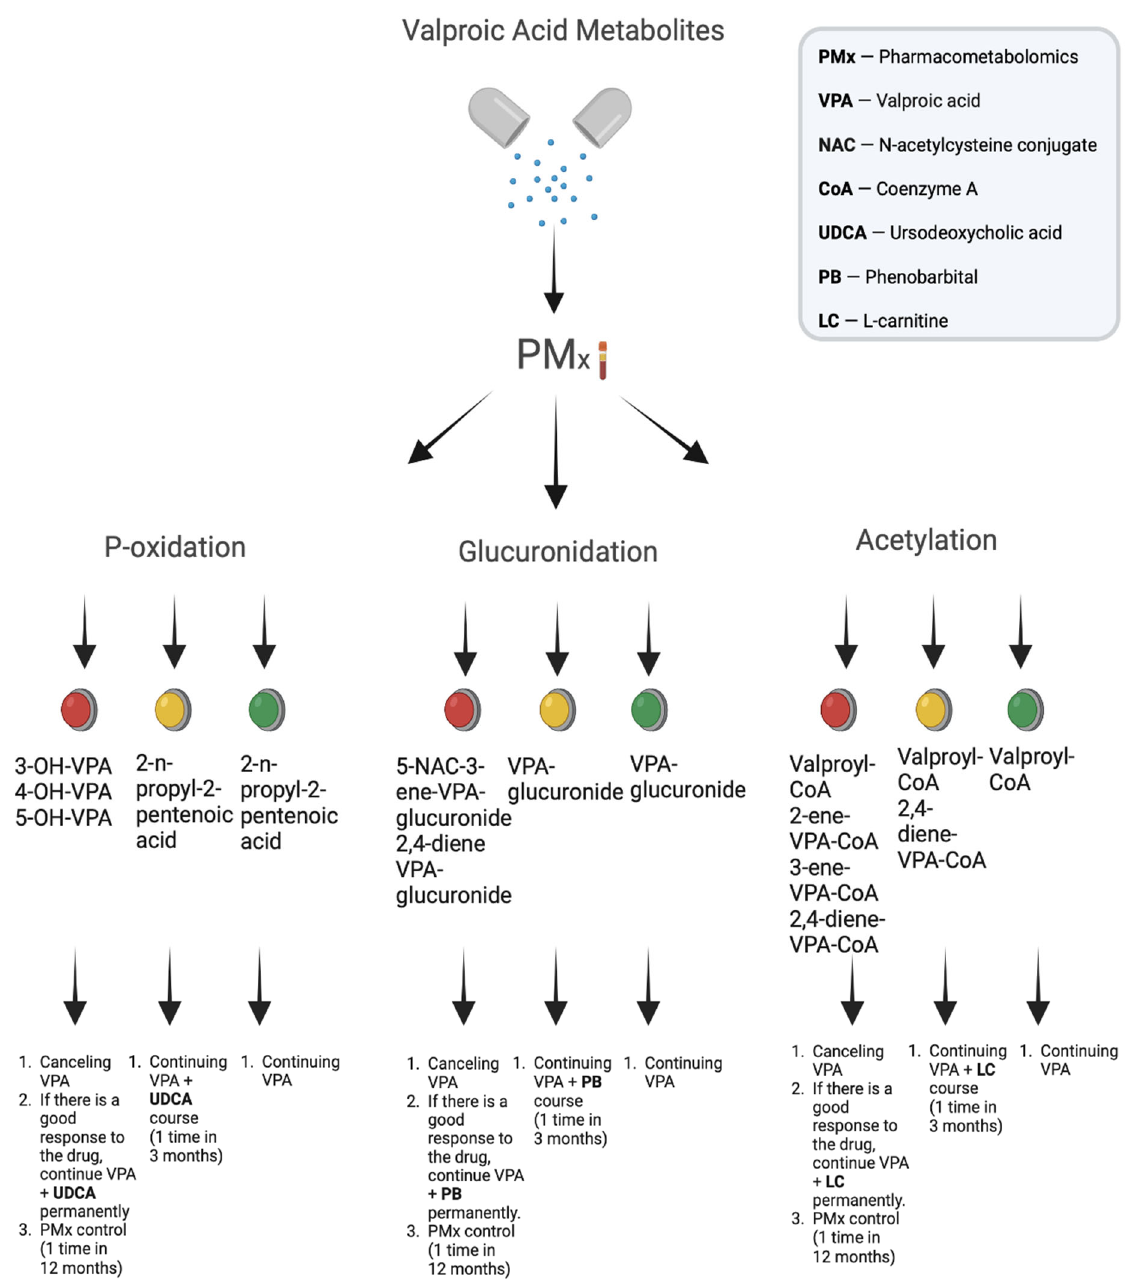
Figure 7. Pharmacometabolomic approach to assessing the risk of development and correction of adverse reactions induced by valproic acid metabolites. The pharmacogenomics and pharmacometabolomics of VPA can be particularly useful when used together (Figure 8).